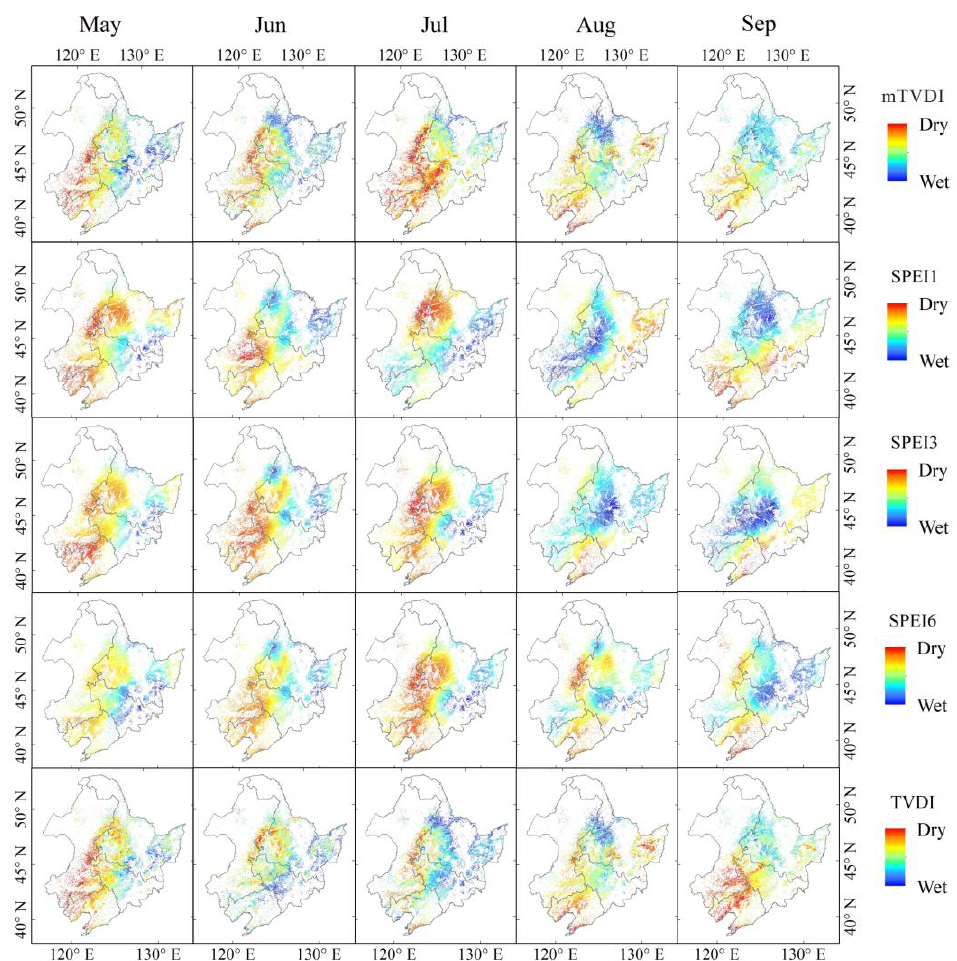
Figure 9. Spatio-temporal drought distribution in Northeast China, indicated by different drought indices, throughout the growth period (May–September) in 2017.